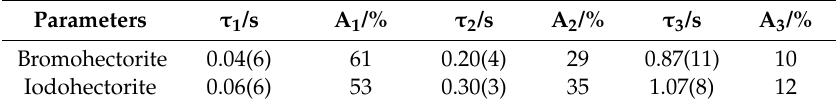
Figure 9. The luminescence decay ( λ exc : 255 nm) of bromohectorite ( λ em : 470 nm) and iodohectorite ( λ em : 490 nm). Table 1. Emission lifetimes calculated for bromohectorite and iodohectorite by fitting the luminescence intensity (I) to the function: I = I 0 + A 1 e − t / τ 1 + A 2 e − t / τ 2 + A 3 e − t / τ 3 . Here, A = amplitude, t = time and τ = lifetime. The values in parentheses show the SD (standard deviation) calculated.